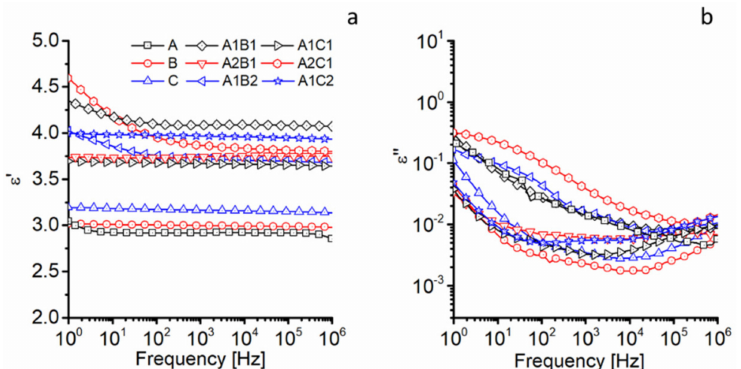
Figure 6. The dielectric spectra of the prepared samples; ( a )–dielectric permittivity, ( b )–dielectric loss. The glass transition temperature domain (T g ) is an important parameter, since it determines polarization conditions and dipole concentration, orientation, and stability.